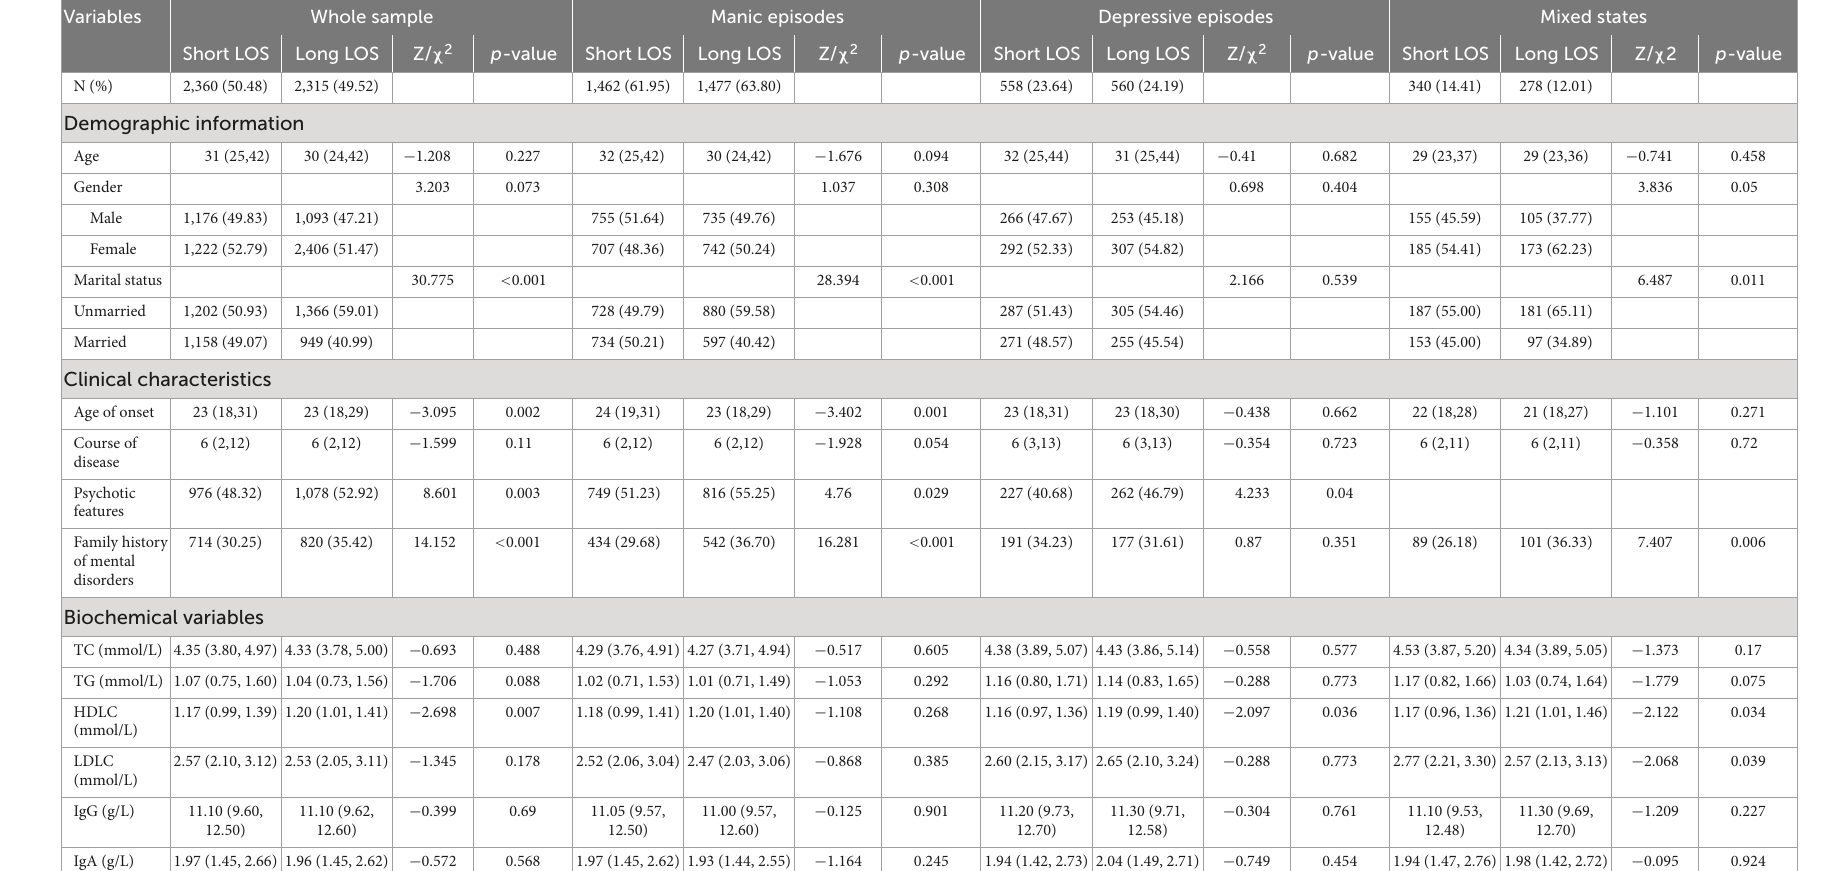
TABLE 2 Univariate analysis of LOS in the whole sample and the three